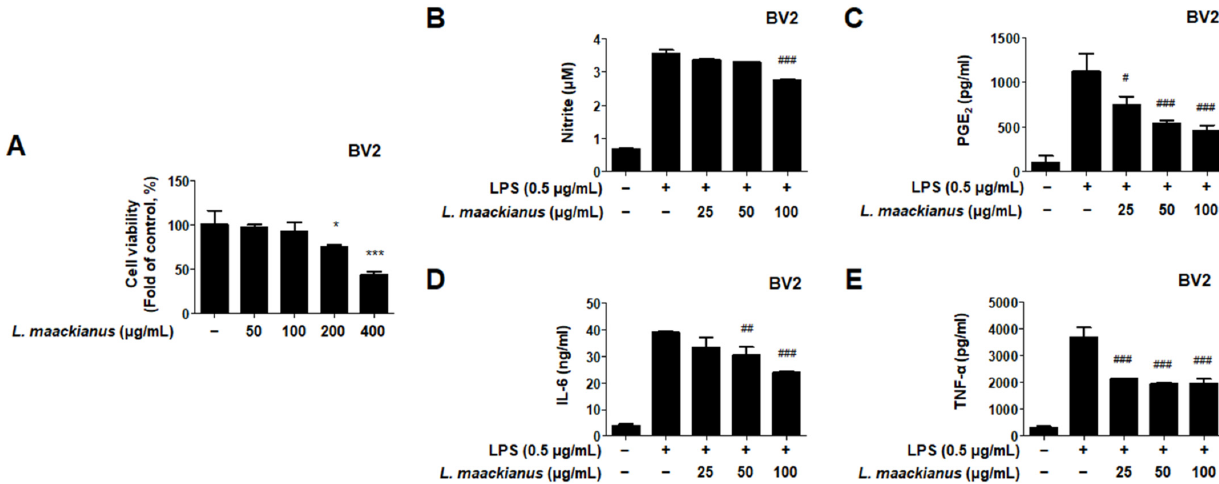
Figure 2. Effect of the MeOH extract of Lycopus maackianus on cytotoxicity ( A ), nitric oxide (NO) ( B ), prostaglandin E2 (PGE 2 ) ( C ), interleukin (IL)-6 ( D ), and tumor necrosis factor (TNF)- α ( E ) levels in BV2 cells. Cells were pretreated with the indicated concentrations of L. maackianus extract for 3 h and stimulated for 24 h in the presence or absence of lipopolysaccharide (LPS; 0.5 µ g/mL). Bars represent the mean ± standard deviation of three independent experiments. Untreated control groups were included. * p < 0.05, *** p < 0.001 compared with control group. # p < 0.05, ## p < 0.01, ### p < 0.001 compared with LPS-treated